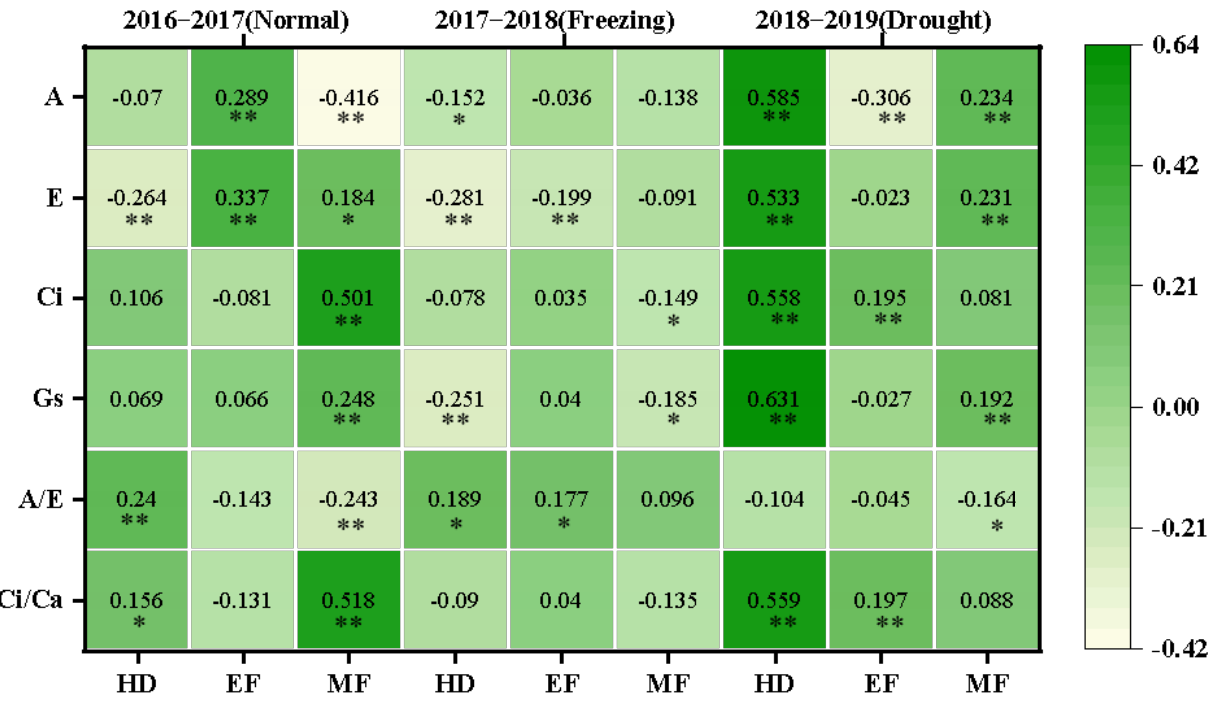
Figure 5. The correlation coefficients between CTDs at three growth stages with photosynthetic parameters at the corresponding stages in the three growing seasons. The correlations were estimated using the Pearson correlations from the SPSS; * and ** indicate the correlations significant for p < 0.05 and p < 0.01, respectively. A: net photosynthetic rate; E: transpiration rate; Gs: stomatal conductance; Ci: intercellular CO 2 concentration; A/E: instant water use efficiency; Ci/Ca: stomatal limitation ratio; HD: heading; EF: early filling; MF: middle filling.